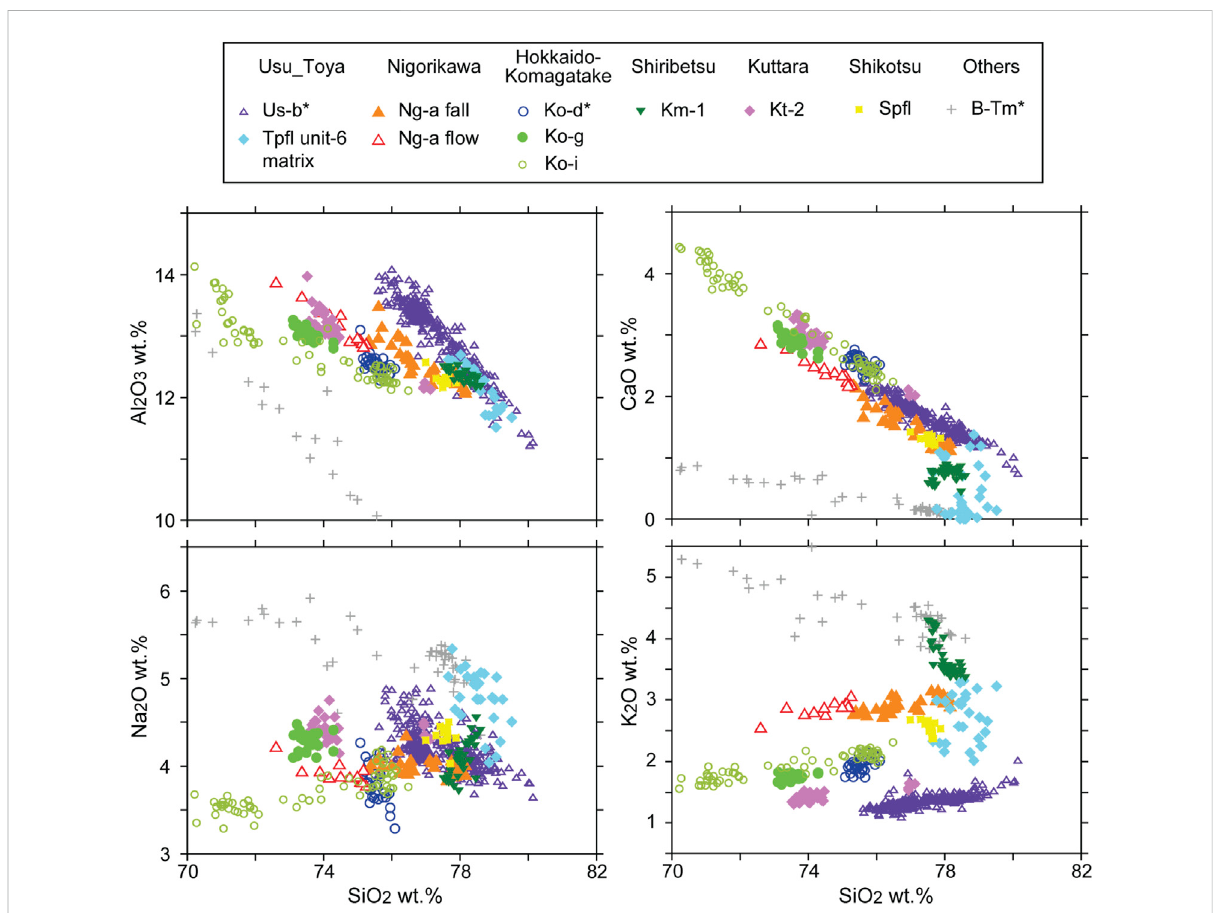
FIGURE 3 Selected SiO 2 variation diagrams for chemical compositions of glass shards from marker tephras recognized around Usu volcano. The distinctive chemical variations of each marker tephra were used to correlate the investigated ash deposits. Asterisks mark tephras whose chemical compositions are determined by the electron probe micro analyzer (EPMA) from Takahashi and Nakagawa (2013), Matsumoto and Nakagawa (2010) and Nakagawa unpublished